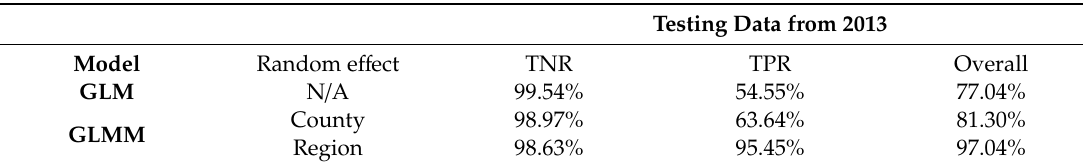
Table 7. Classification accuracy for the validation and testing datasets by the GLM (Generalized Linear Model) and GLMM, where TNR: true negative rate; TPR: true positive